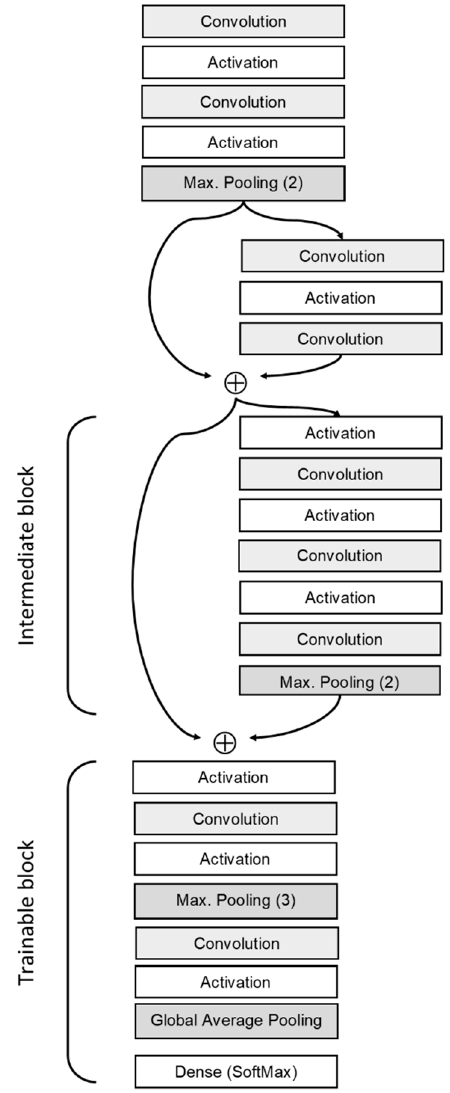
Figure 3. Architecture of the deep convolutional neural network (CNN). Overall drawing displays the general characteristics of the CNNs. The arrows show the residual shortcuts (ResNet). The number of intermediate blocks was adjusted according to the hyperparameter tuning results. The weights of the trainable block were tuned in the transfer-learning analysis. For a detailed drawing of the final models, see the supplementary online files.